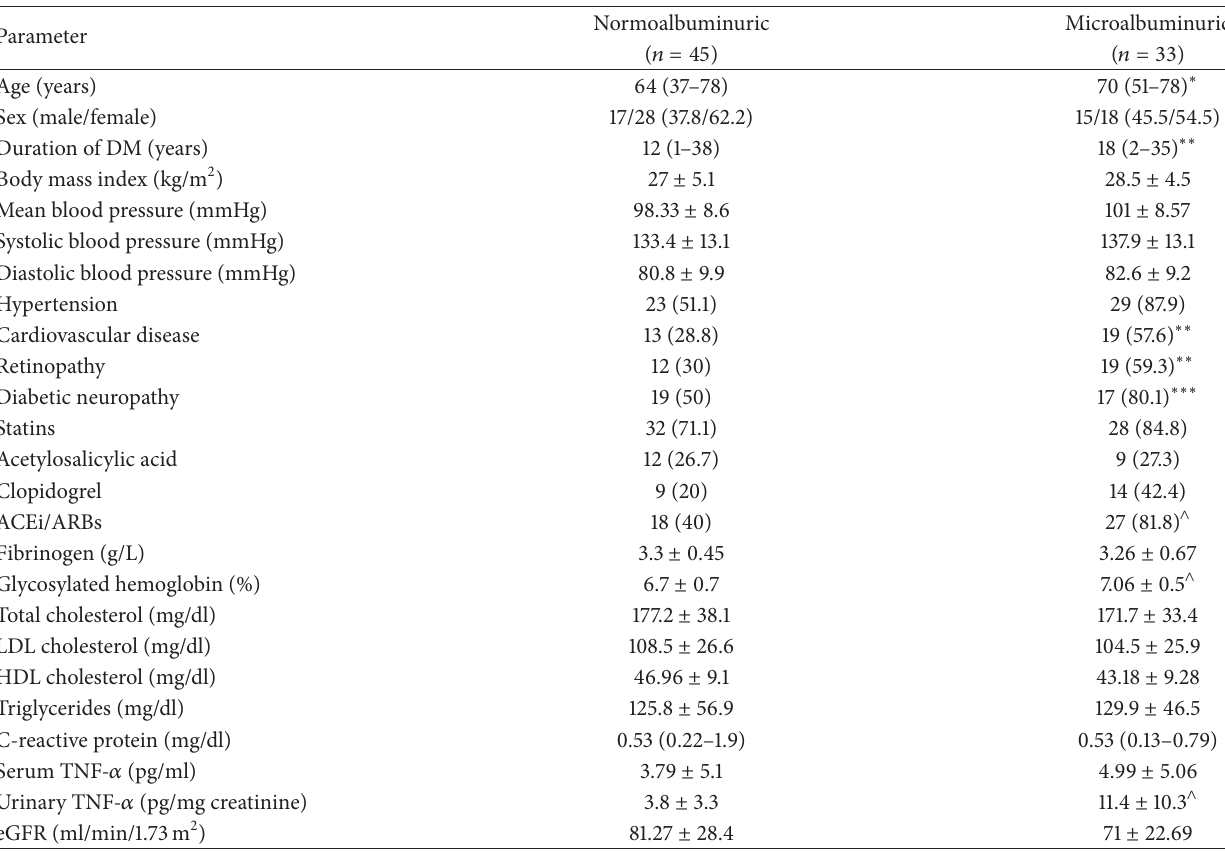
Table 3: Demographic, anthropometric, and clinical characteristics, prescribed drugs, and laboratory findings in diabetic patients with normoalbuminuria and